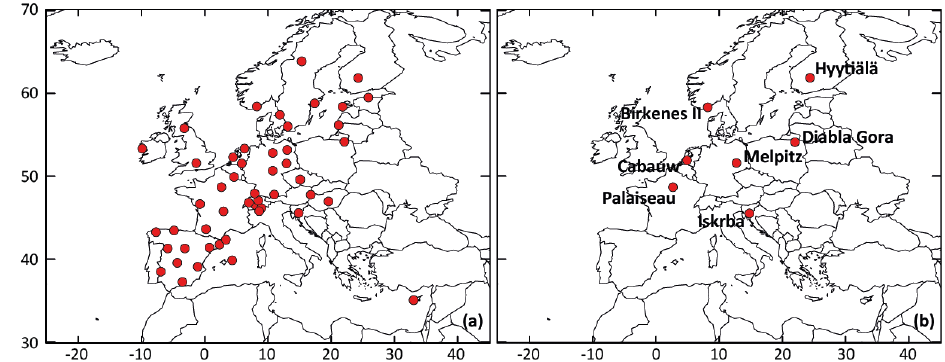
Figure 1. Location of rural background stations used for (a) the statistical evaluations and (b) time series